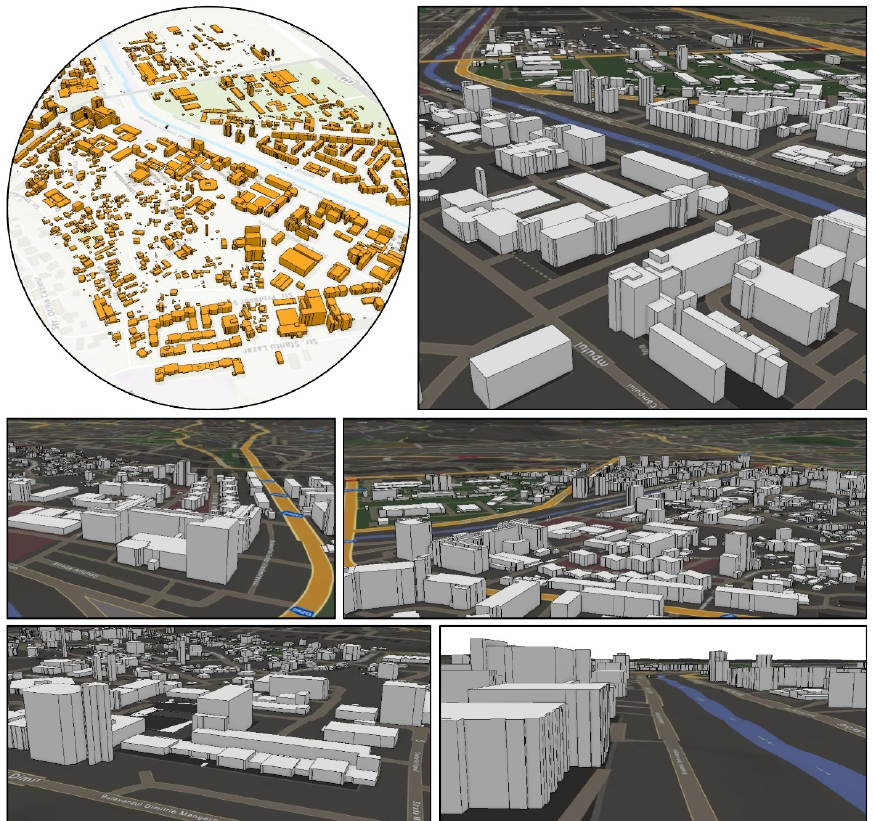
Figure 26. Three-dimensional building reconstruction based on the median height.